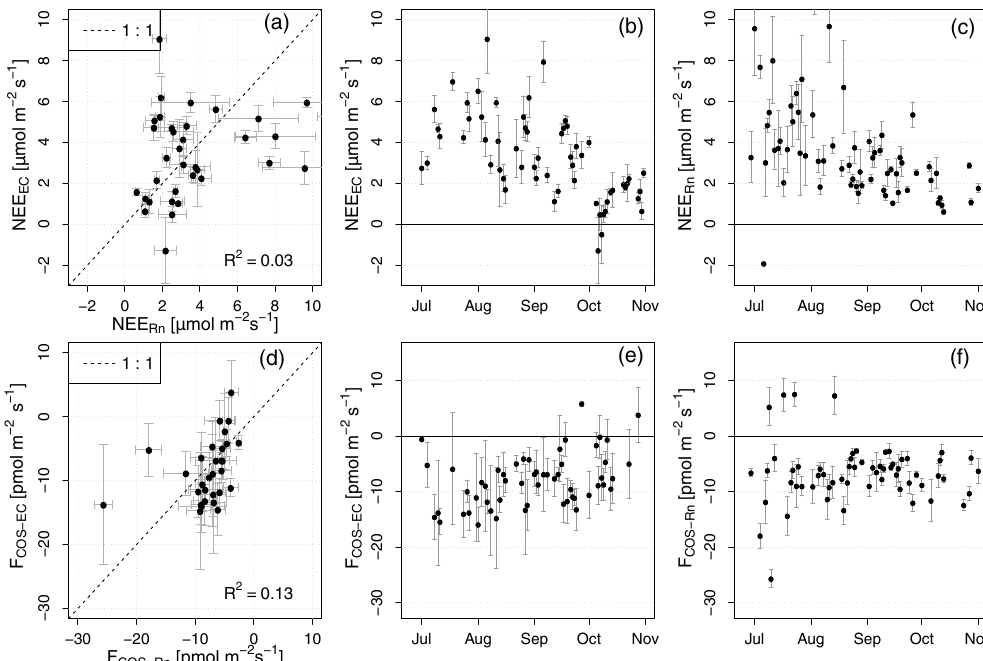
Figure 4. (a, d) Comparison of EC- and radon-based fluxes for average nighttime CO 2 (a) and COS (d) fluxes. (b, c, e, f) Time series of EC based fluxes (b, e) and radon-based fluxes (c, f) . The uncertainty bars of the EC and radon-based fluxes are not directly comparable due to the different ways of determining these